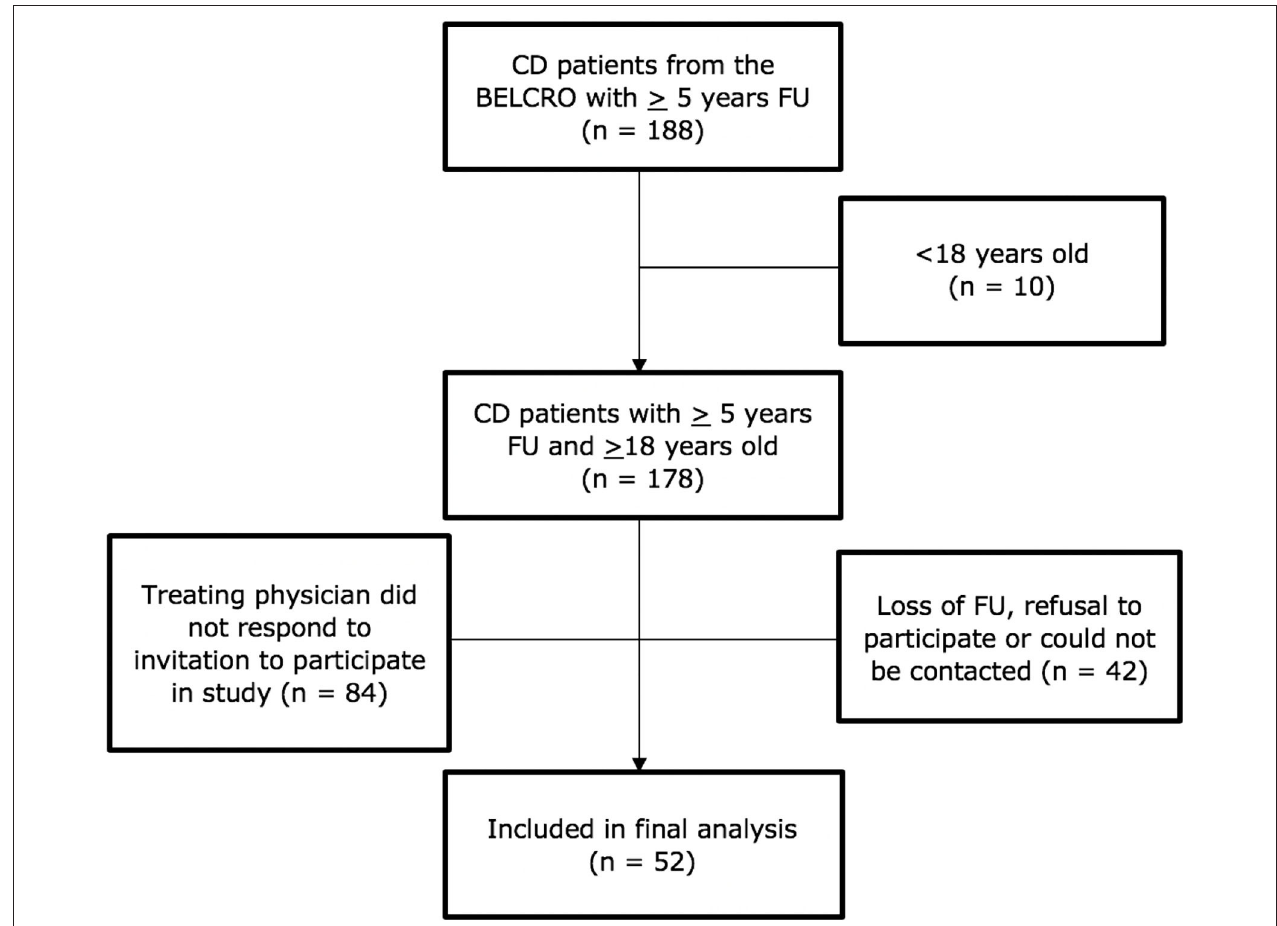
FIGURE 1 | Patient flowchart for CD. BELCRO, BELgian pediatric CROhn’s Disease Registry; CD, Crohn’s Disease; FU, Follow-up.